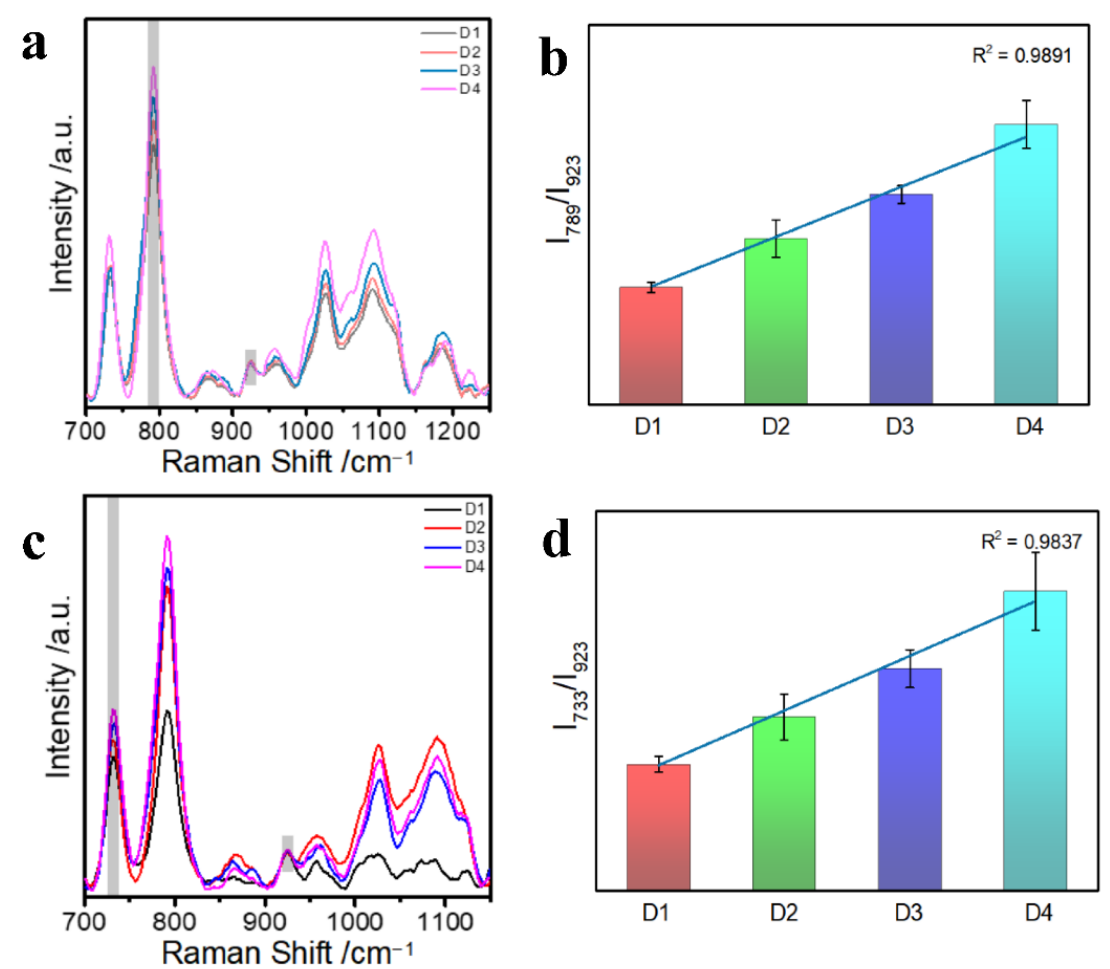
Figure 3. ( a , c ) SERS spectra of Au@AgNPs with different dsDNA lengths (D1, D2, D3, D4); ( b ) Histogram of I 789 /I 923 values corresponding to cytosine (C) and thymine (T) changes in different lengths of dsDNA; ( d ) histogram of I 733/ I 923 values corresponding to adenine (A) changes in different lengths of dsDNA.